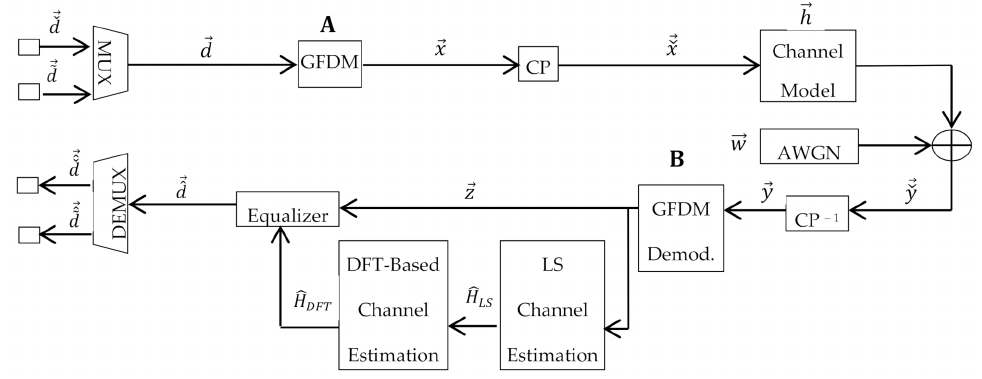
Figure 1. GFDM channel estimation block